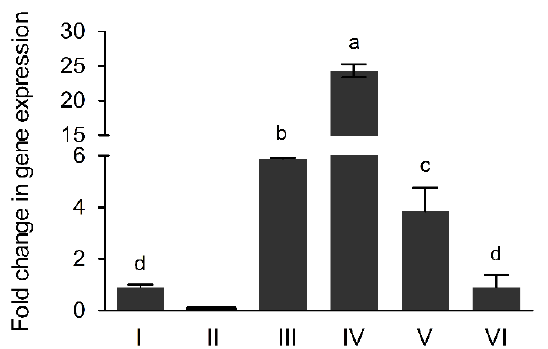
Figure 1. The AcdS gene expression levels in Pseudomonas sp. UW4 and derivative strains cultivated in LB medium plus ACC for 10 h. I, UW4; II, UW4 ∆ AcdS ; III, UW4 ∆ AcdS + PA- AcdS ; IV, UW4 ∆ AcdS + PB20- AcdS , V, UW4 ∆ AcdS + PB10- AcdS ; VI, UW4 ∆ AcdS + PB1- AcdS . All data are mean value of biological triplicates. Error bars represent standard errors. Data marked with different lowercase letters were statistically different at p < 0.05 based on the least significant difference (LSD) multiple comparison test.